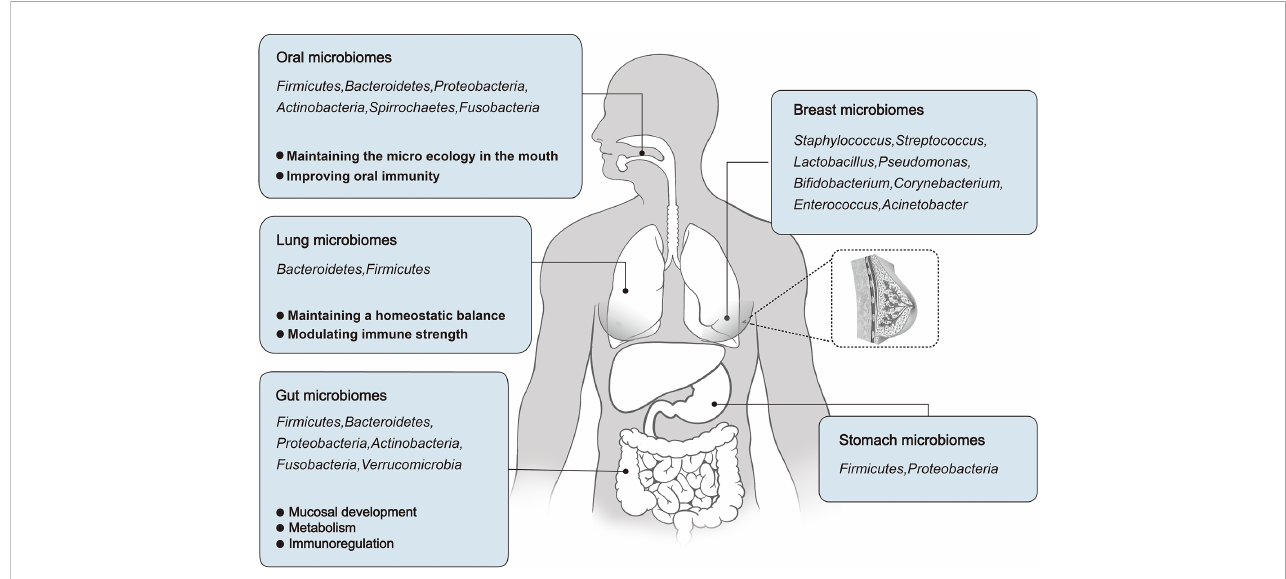
FIGURE 1 An overview of the microbial distribution in human body, and the roles of Oral, Lung, and Gut microbiomes in human development and physiological